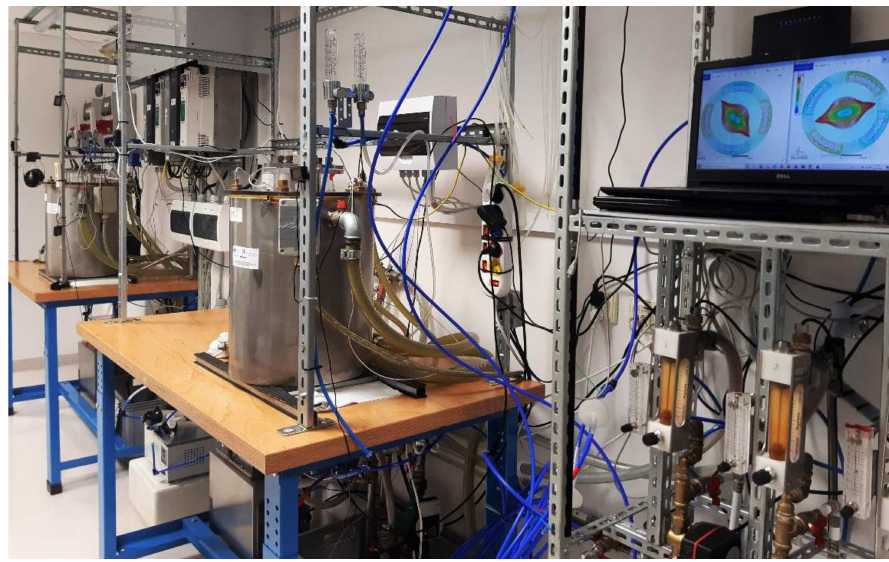
Figure 6. RMF generator with monitoring and control